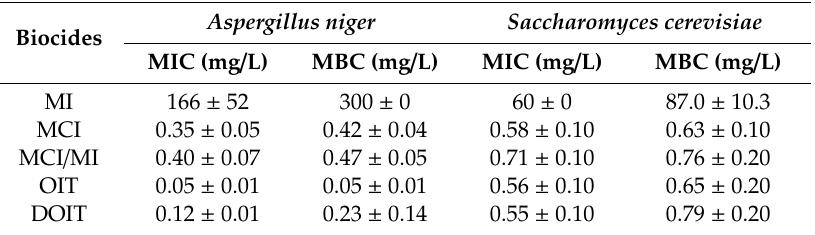
Table 2. MIC and minimum biocidal concentration (MBC) values for MI, MCI, MCI / MI, OIT, and DCOIT against Aspergillus niger and Saccharomyces cerevisiae . Values reported ± standard deviation of three to five replicates